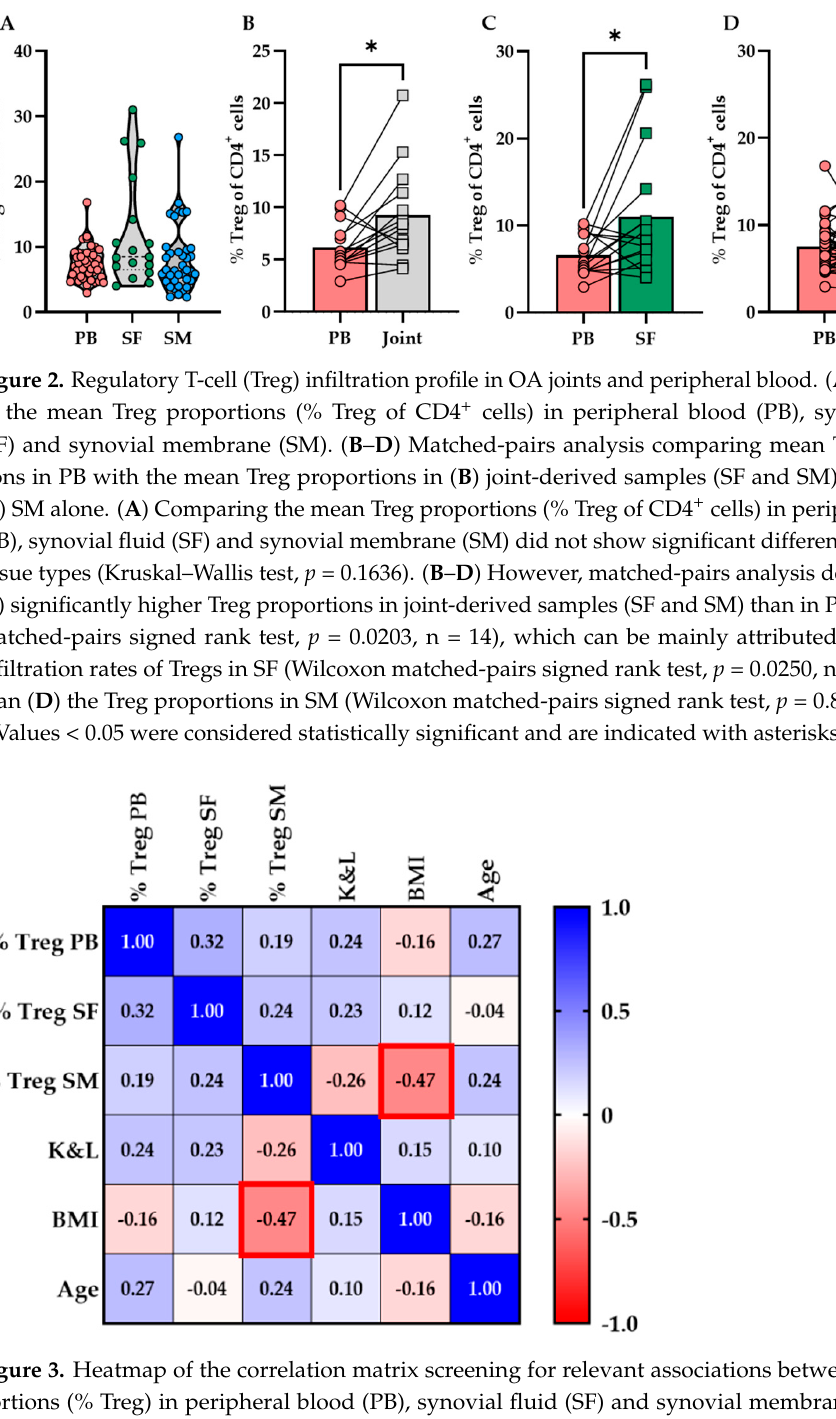
Figure 2. Regulatory T-cell (Treg) infiltration profile in OA joints and peripheral blood. ( A ) Over-